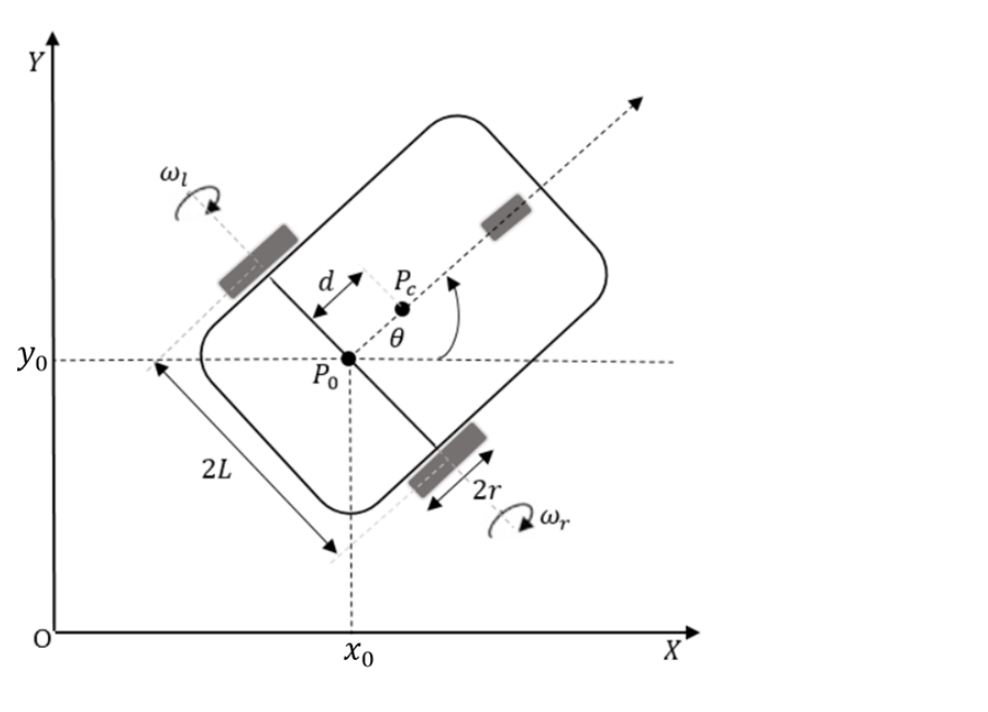
Figure 1. The wheel mobile